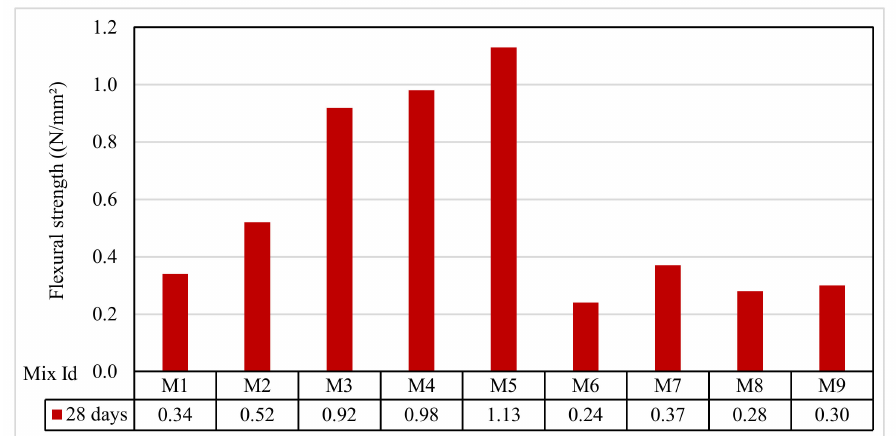
Figure 10. The flexural strength test results.